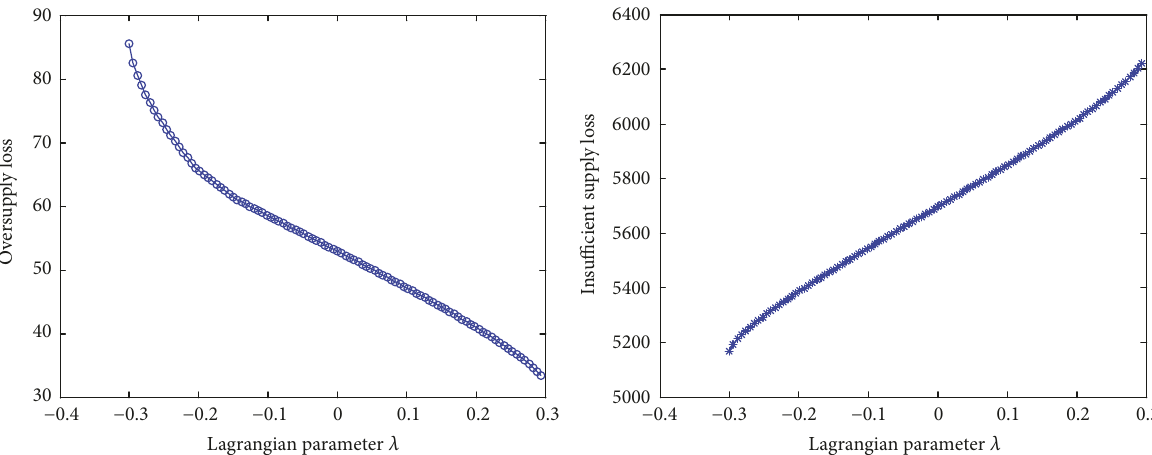
Figure 3: Oversupply loss and insufficient supply loss under different 𝜆